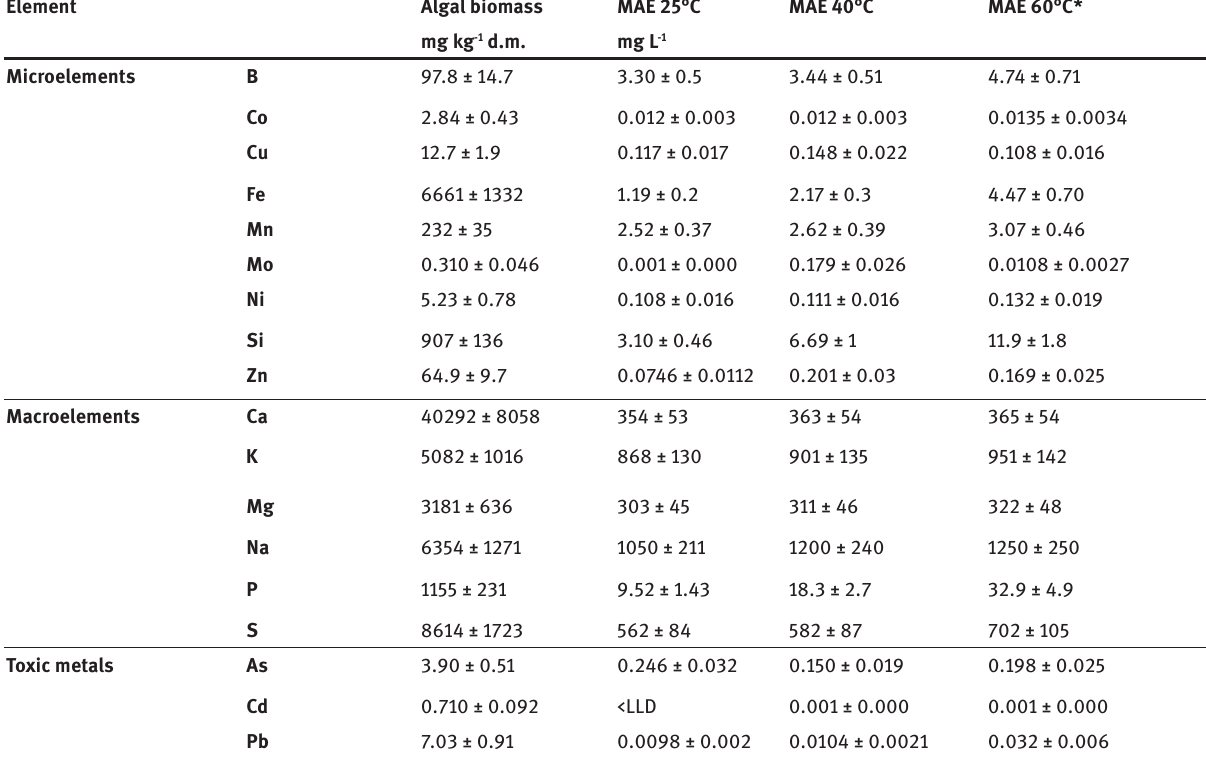
Table 2: Multielemental composition of raw algal biomass and extracts obtained by MAE.